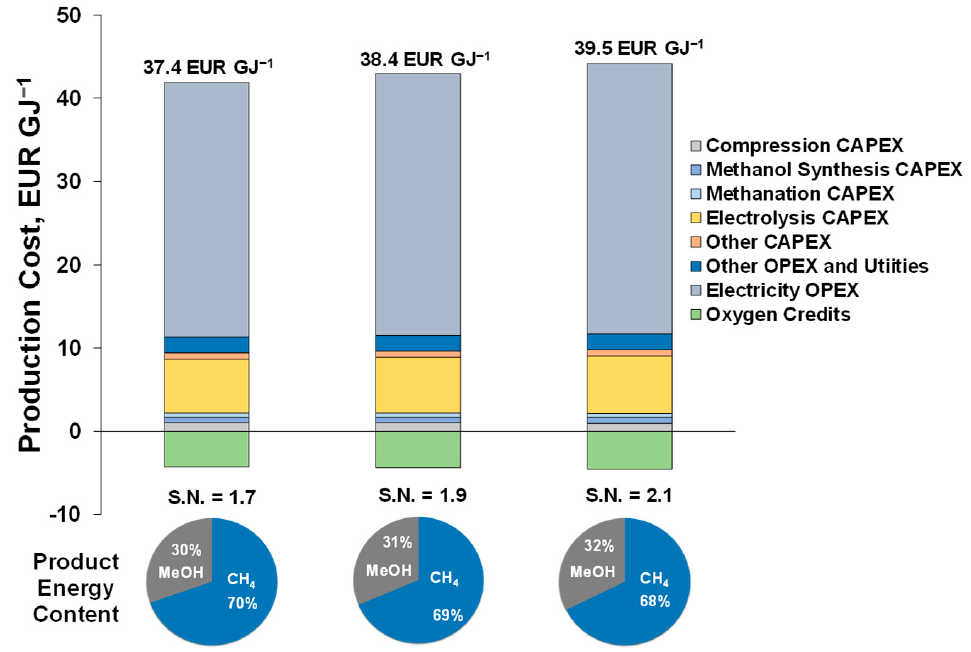
Figure 16. Effect of the stoichiometric number on total production costs in the combined case.